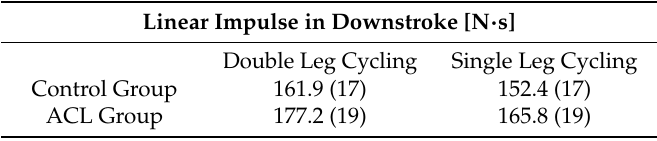
Table 3. Average linear impulse in the downstroke (no significance was found; p <